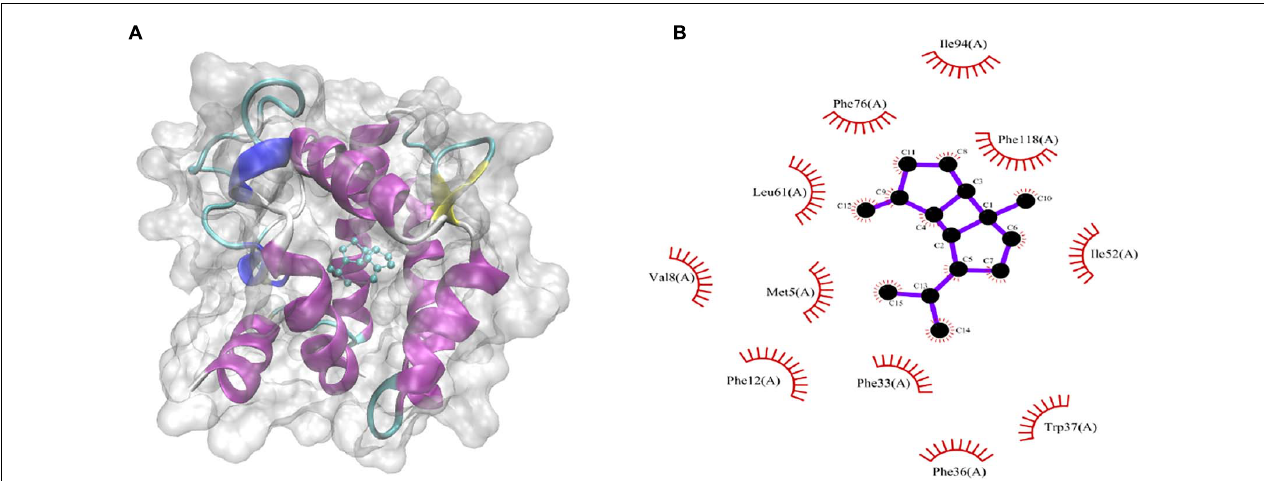
FIGURE 7 | Molecular docking of CpomGOBP1 with β -bourbonene. (A) β -bourbonene located in the binding cavity of CpomGOBP1 . (B) Key amino acid residues that interact with β -bourbonene.